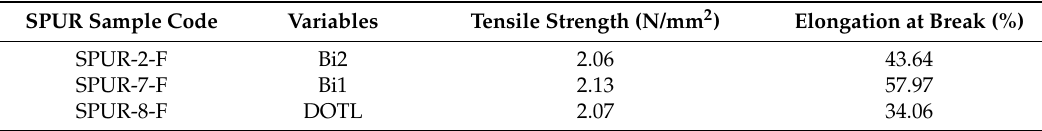
Table 11. The mechanical test results of cured SPUR with different